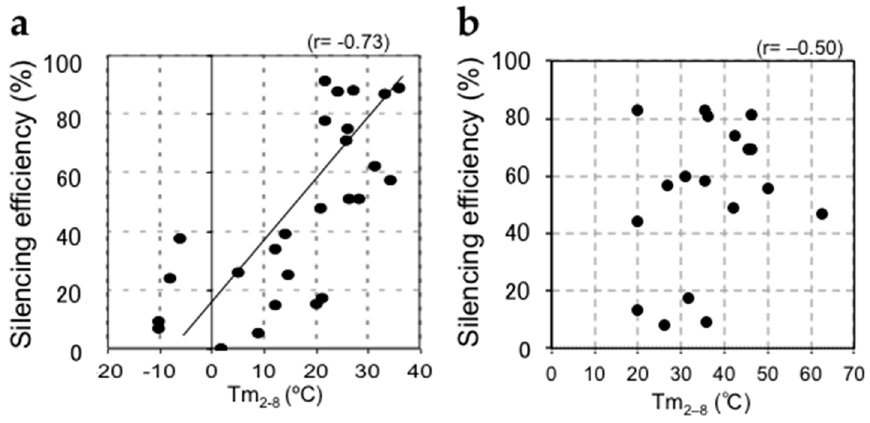
Figure 2. Cont. Figure 2.